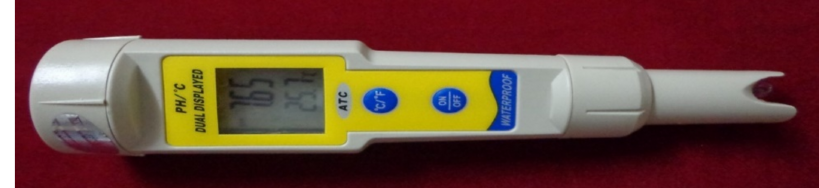
Figure 1. Digital single electrode Ph